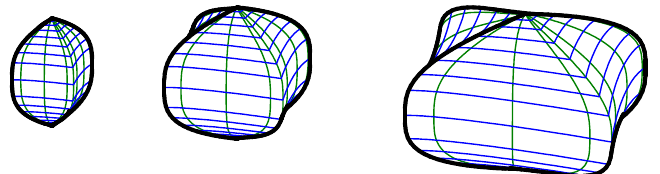
Figure 8. Spheres of radii 0.9, 1.1, and 1.3 and exponents p 1 = 1, p 2 = 0.8, p 3 = 3.